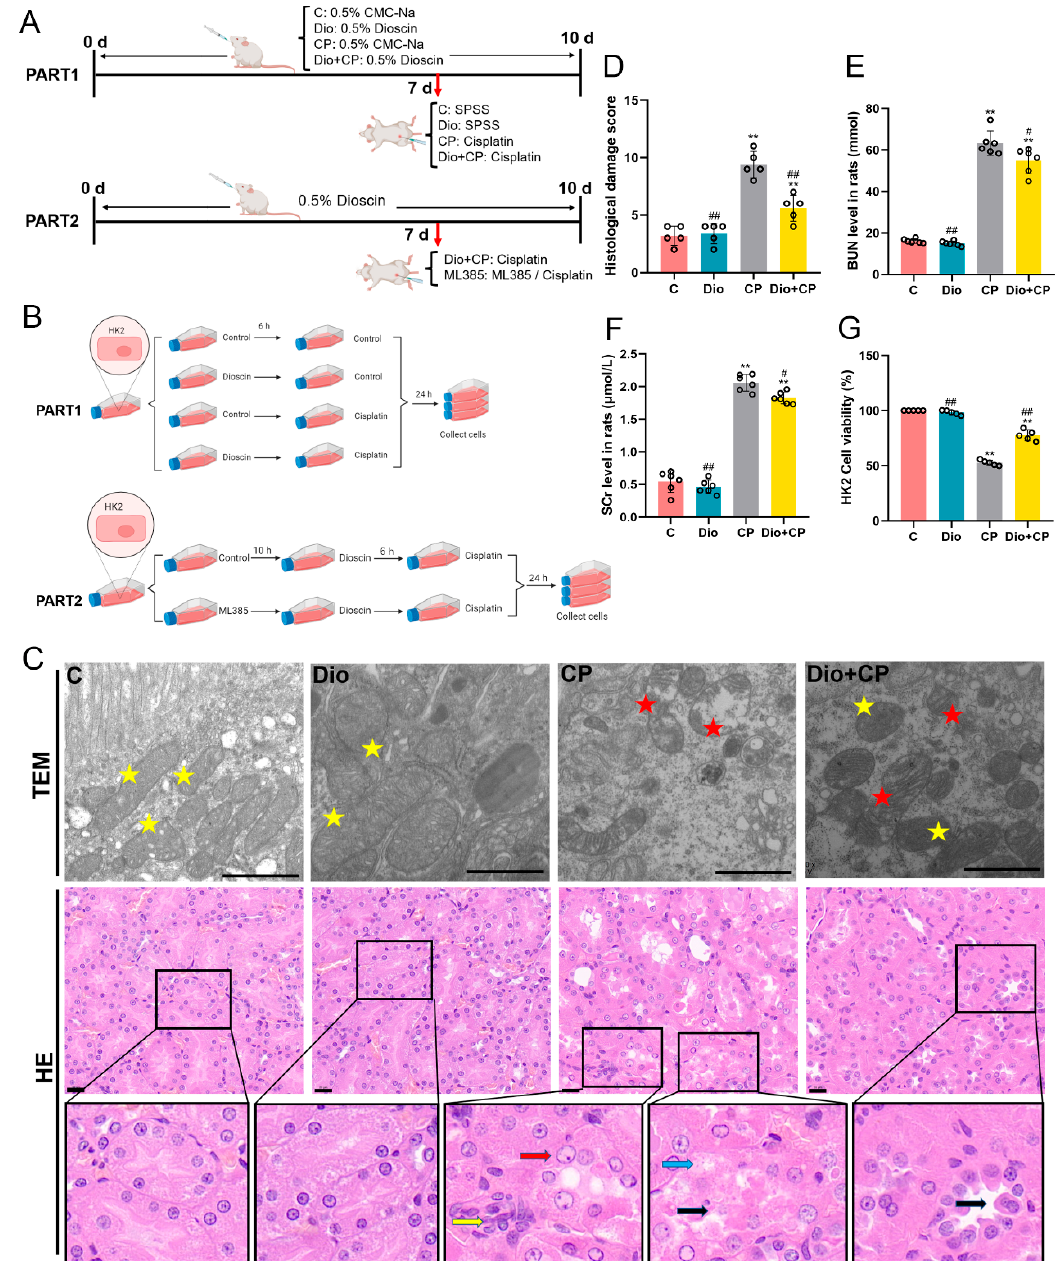
Figure 1. Dioscin relieves cisplatin-induced AKI. ( A ) Schematic representation of animal study design in the present study. SPSS, stroke-physiological saline solution. ( B ) Schematic diagram of cell experiment design. ( C ) Transmission electron microscope (scale bar = 1 μ m) and H&E staining (scale bar = 20 μ m) of rat kidney tissue (n = 5). Yellow pentagram, normal mitochondria; red pentagram, damaged mitochondria; red arrow, abnormal nucleus; yellow arrow, inflammatory cell infiltrated; blue arrow, renal tubular epithelial cell degeneration; black arrow, renal tubular epithelial cell desquamation. ( D ) Histological damage score. ( E , F ) Bun and SCr levels in rat serum (n = 6). ( G ) HK2 cell activity. C, control group; Dio, dioscin group; CP, cisplatin group; Dio + CP, dioscin + cisplatin group. Results are presented as Mean ± SD. Statistical significance was obtained by one-way ANOVA. ** p < 0.01 compared with C group. # p < 0.05, ## p < 0.01 compared with CP group.